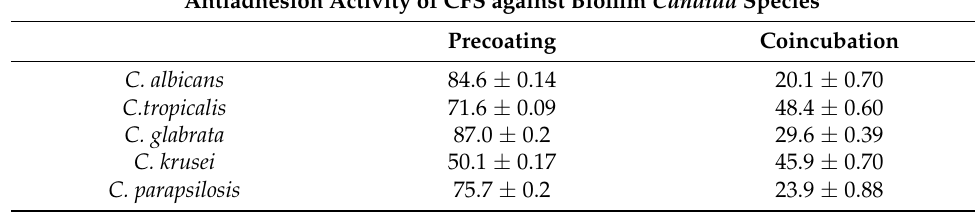
Table 7. Percentage values of antiadhesion activity of CFS against Candida spp.